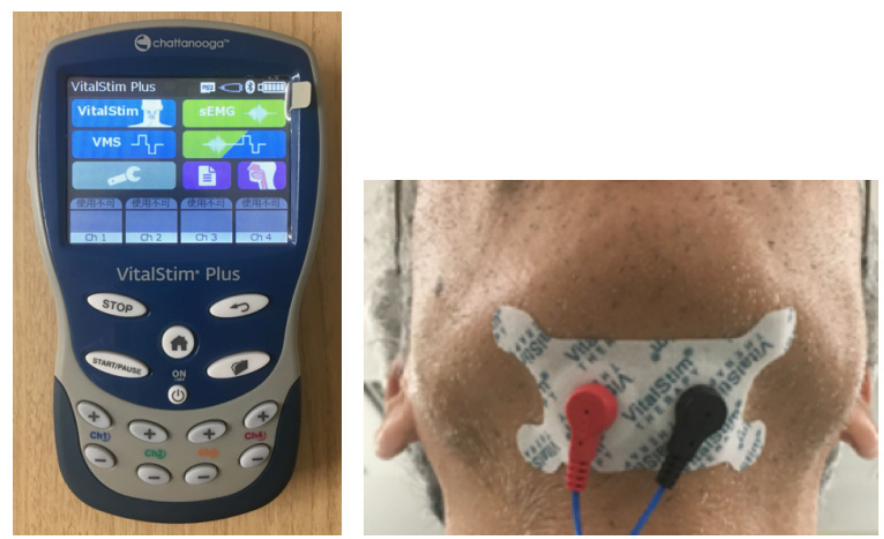
Figure 6. Neuromuscular electrical stimulation system (VitalStim ® Plus). The electrodes were at- tached to the submental